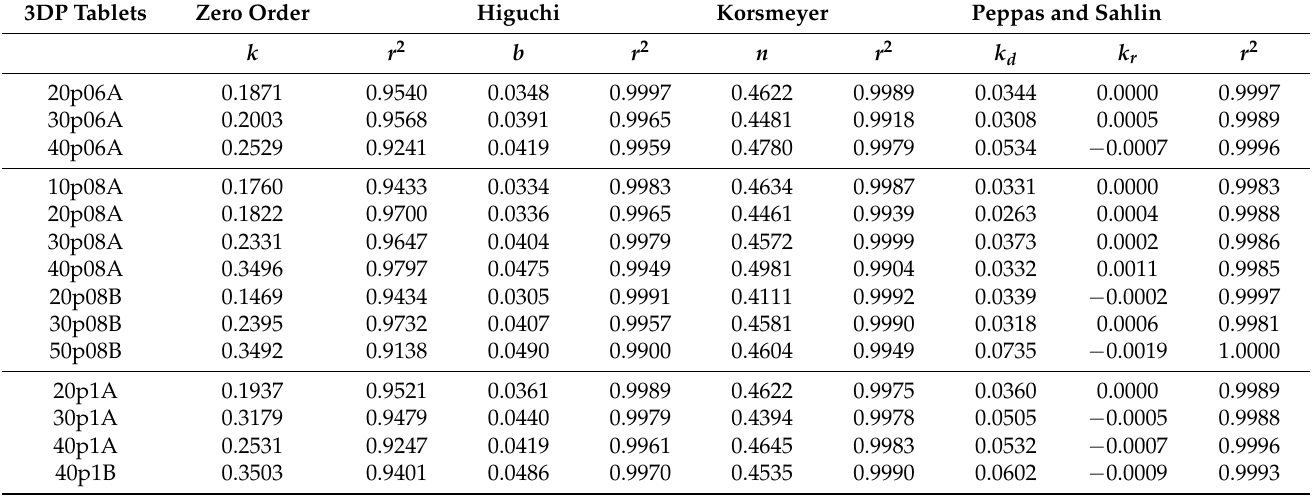
Table 3. Drug release kinetic parameters of the 3DP tablets. B, Higuchi kinetic constant; n , release ex- ponent; k d , Peppas diffusion kinetic constant; k r , Peppas relaxation kinetic constant; r 2 , determination